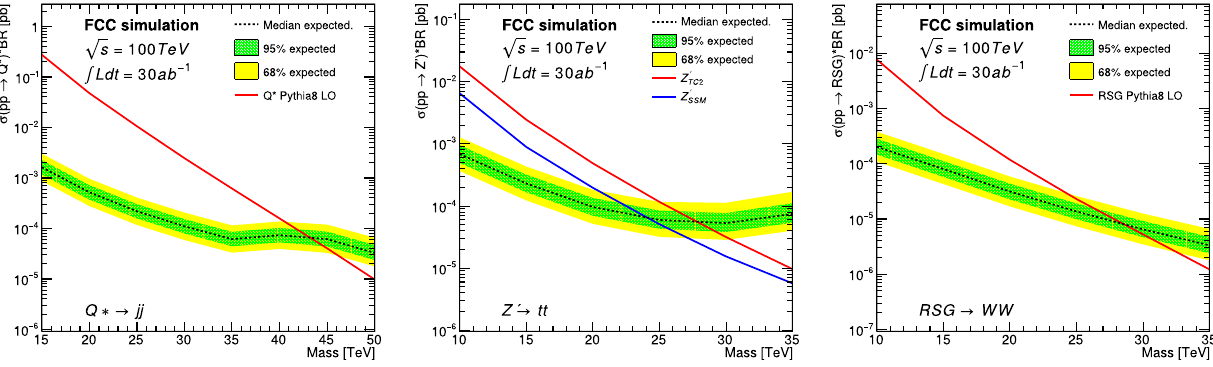
Fig. 15.7 Sensitivity to various resonance models using fully hadronic final states. For left to right: excited quarks Q ∗ in the dijet channel; Z (cid:3) in the t ¯ t hadronic channel (SSM and top-assisted technicolour [389], TC2, models); G RS in the WW fully hadronic channel. From Ref.